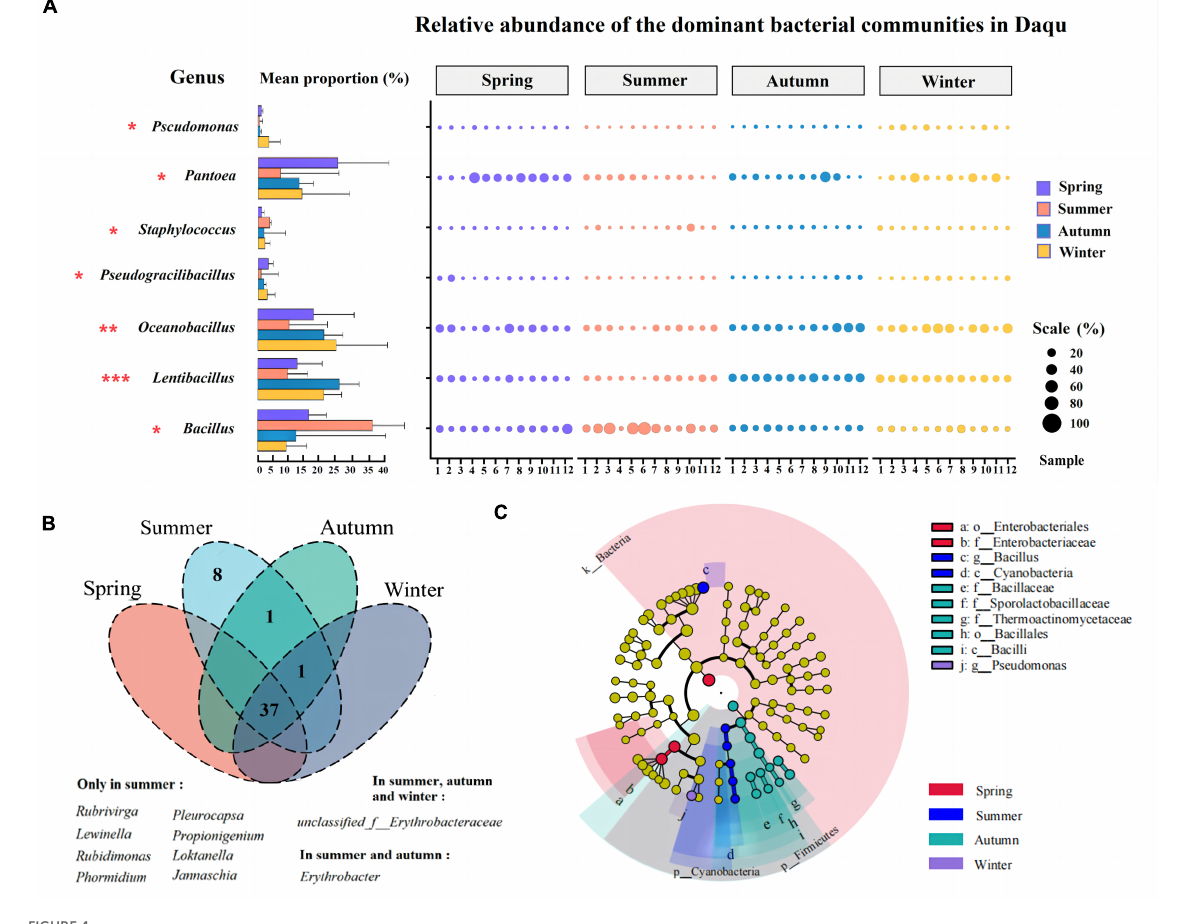
FIGURE4 Changes and significant differences of the dominant bacterial genera ( > 0.1%) and the core bacterial genera ( > 1%) in the 48 Daqu samples produced in four seasons, as determined via the Kruskal-Wallis H test bar plot and abundance bubble map (A) , venn (B) , LEfSe (C) . * P < 0.05, ** P < 0.01, *** P <